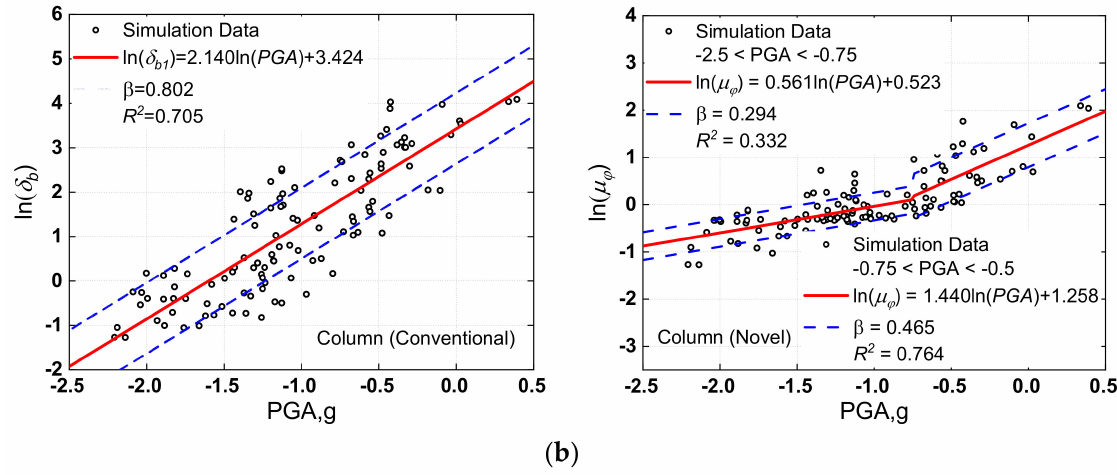
Figure 11. Probabilistic seismic demand models of column (pier): ( a ) Sa1.0 versus column curvature ductility responses, ( b ) PGA versus column curvature ductility